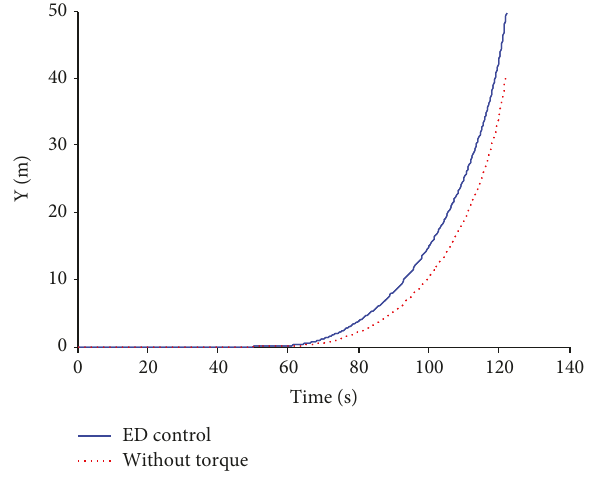
Figure 9: Left and right in-wheel motor torque. Figure 12: Comparison of vehicle trajectory.